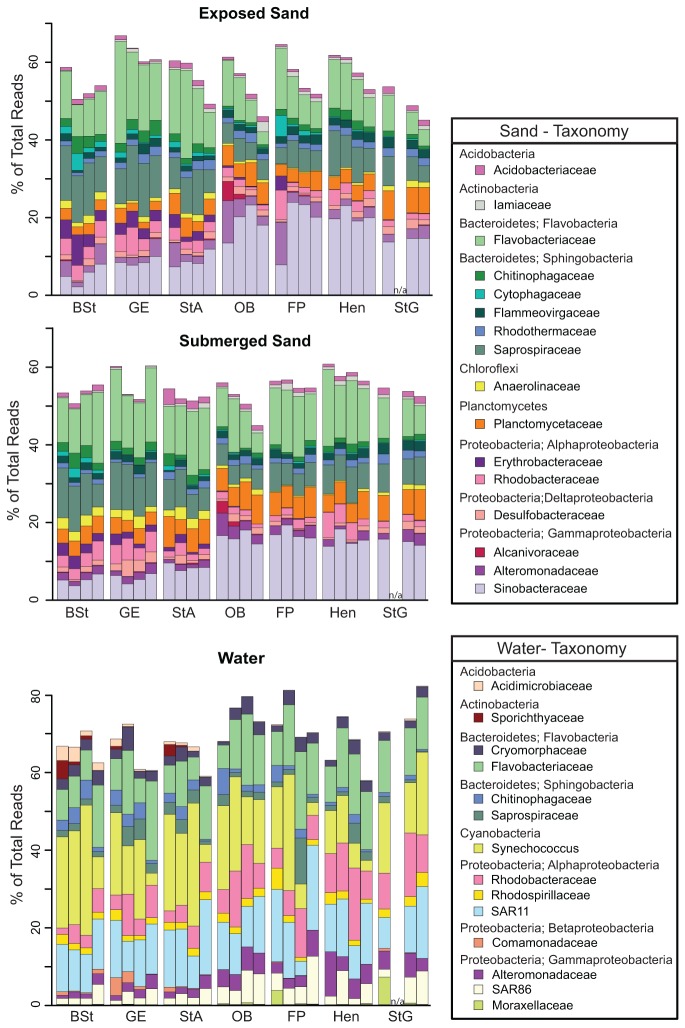
Family-based taxonomic representation of each bacterial community.Families were only included in the plot when they were among the top-5 most abundant families in at least one of the samples. Sand and water family rankings were treated independently. The average family composition is represented for all beach – date combinations containing multiple sequenced samples.